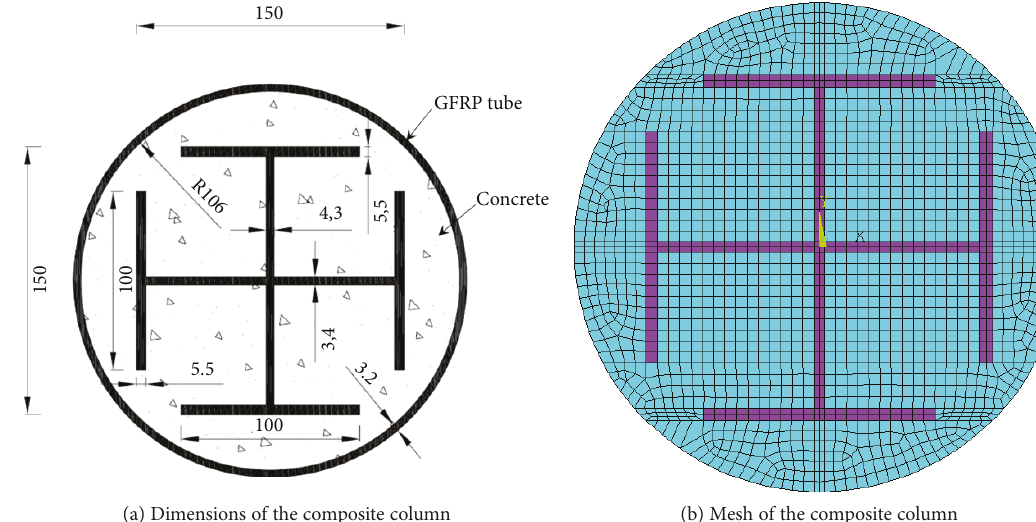
Figure 9: Dimensions and mesh of the composite column with a cross-shaped steel.